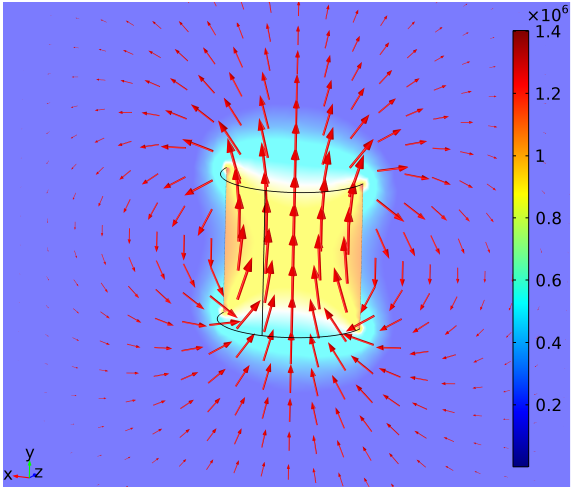
Figure 2. Finite element model of a cylindrical dipole’s magnetic field. Color: magnetic density norm ( µ T). Arrow (logarithmic): flux